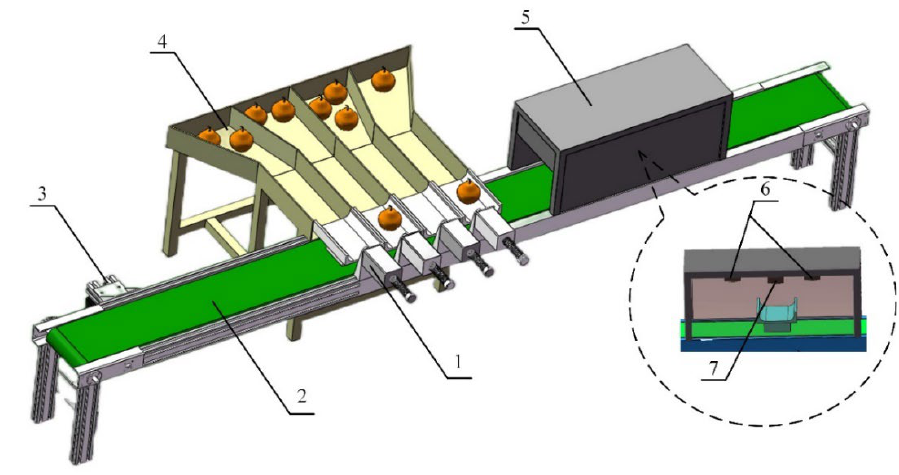
Figure 9. Design appearance of pear appearance quality inspection and grading system. 1—Push-pull electromagnet, 2—Conveyor, 3—Motor, 4—Storage box, 5—Image acquisition cabin, 6—Light source, 7—CCD color camera.